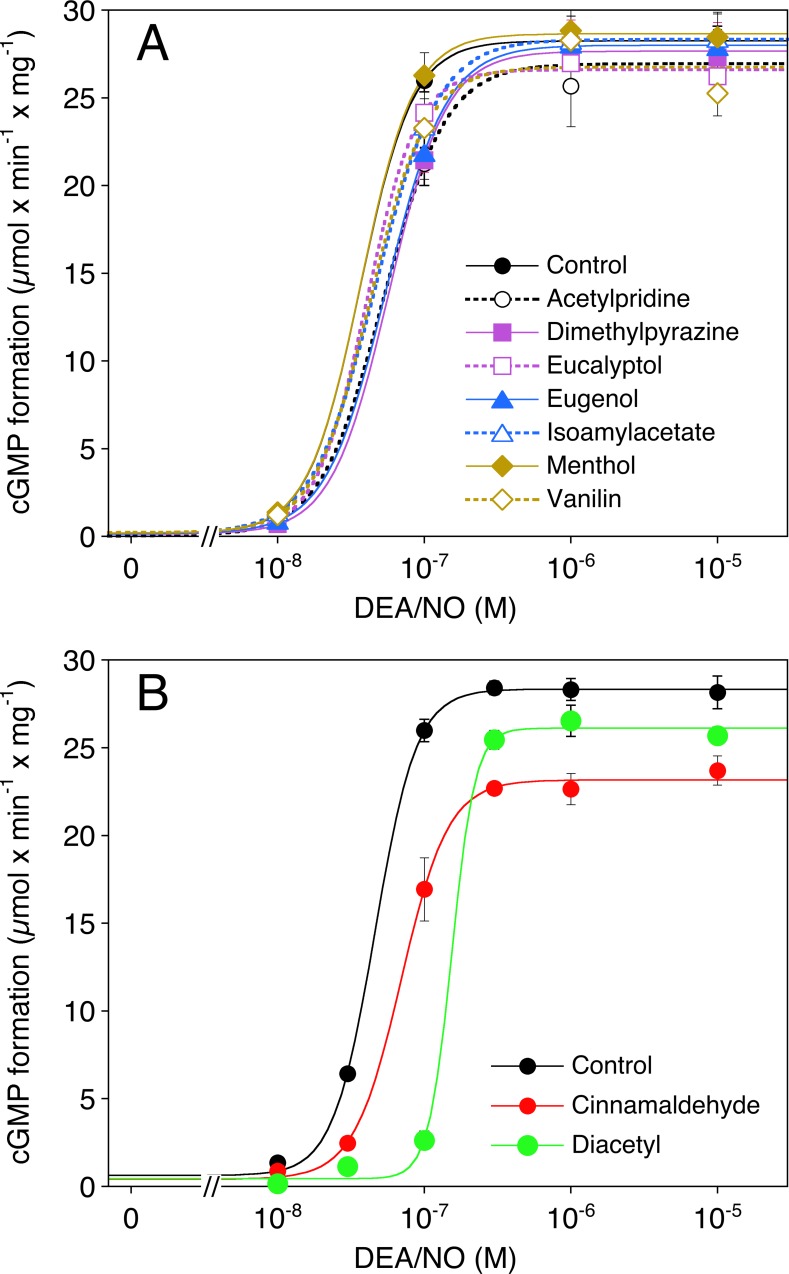
Effect of flavorings on sGC activity.Purified bovine lung sGC (50 ng) was stimulated with increasing concentrations of DEA/NO (0.01–10 μM) in the presence of DMSO (0.1% as solvent control) or flavorings (1 mM each). Formation of cGMP was determined as described in Materials and methods. Data are expressed as mean values±SEM (n = 3). For clarity, the effects of cinnamaldehyde and diacetyl compared to control are shown separately in panel B.